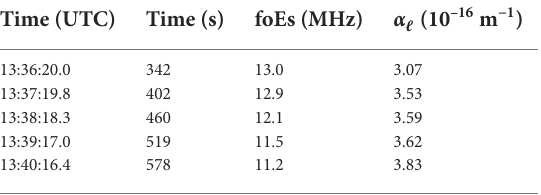
TABLE 2 Plasma-frequencies and line densities as a function of time after the meteor entry.